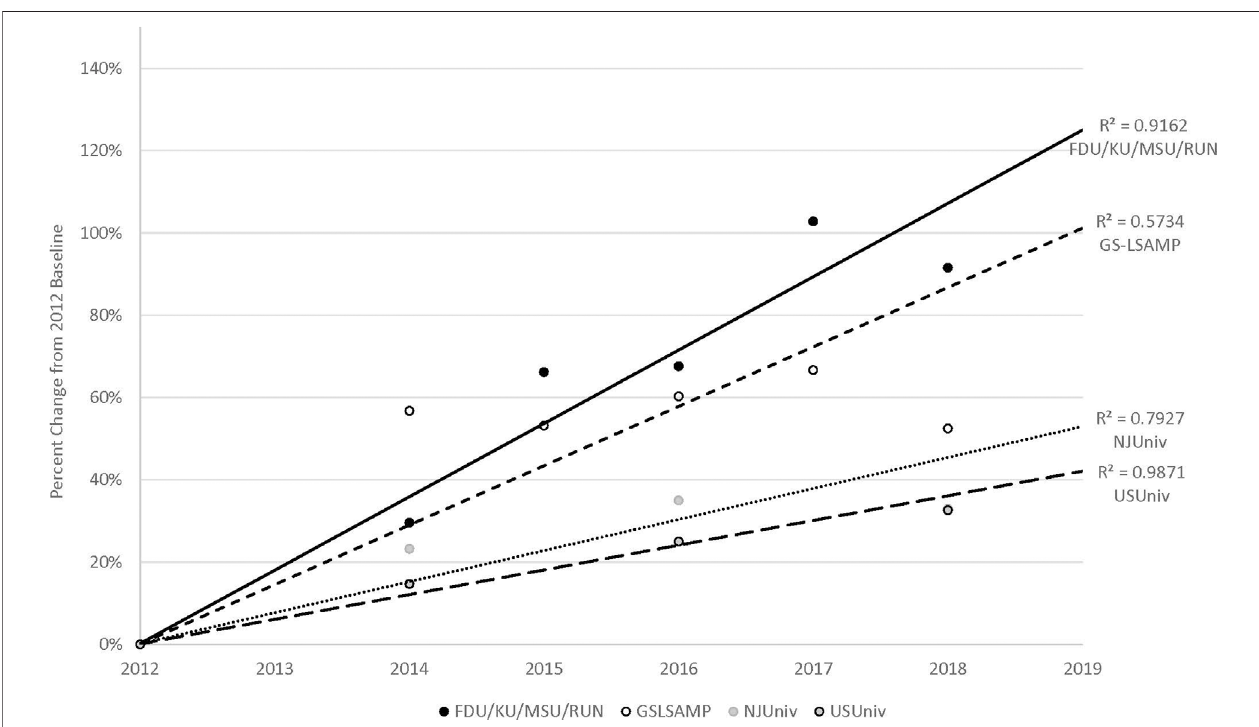
FIGURE 4 | URM STEM Transfer-In students from NNJB2B to four of the GSLSAMP schools (Fairleigh Dickinson University, Kean University, Montclair State University and Rutgers University-Newark) versus URM STEM Transfer-In students from all public 2-year schools to all non-religious 4-year schools in New Jersey (NJUniv,n (cid:1) 30)andintheUnitedStates(USUniv,n (cid:1) 1429)asreportedtoIPEDS.Datashownaspercentincreasefromthe2012baseline,(IPEDSdatafor fi eldofstudy are only available for even years